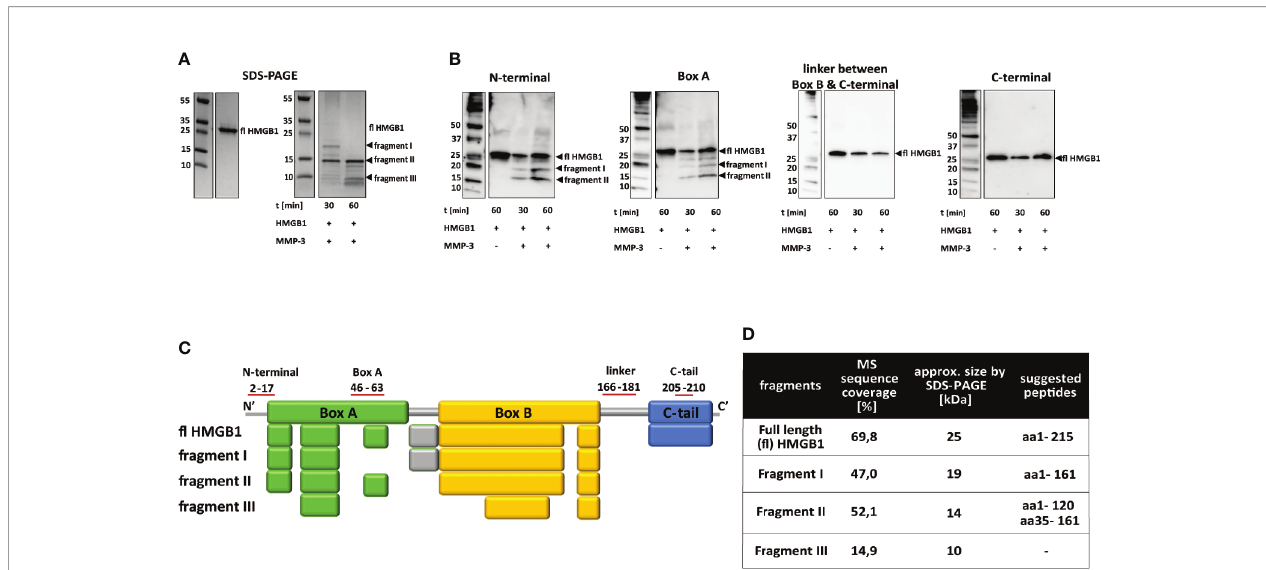
FIGURE 4 | MMP3 cleaves HMGB1 at multiple sites. (A) Left panel: SDS-PAGE showing full length HMGB1. Right panel: SDS-PAGE showing cleavage by MMP3 over time. Two distinct fragments of approximately 19 and 14 kDa (I and II) appeared at time point 30 min. At 60 min, fragment I had disappeared while fragment II was still the dominant fragment. (B) Western blotting of HMGB1 fragments after processing with MMP3. A fragment corresponding to fragment I in size was detected by the antibodies speci fi c for epitopes in the N-terminal region and in the box A region. In agreement with the SDS-PAGE kinetic pattern, the staining was stronger at the 30-min time point than the 60-min time point. Antibodies speci fi c for epitopes within the B-to-C linker region and the C-terminal region only detected full length HMGB1 and none of the fragments. (C) Gel bands of HMGB1 fragments I-III were analyzed by mass spectrometry and the resulting peptides were compared to peptides detected in the full length protein. Colored boxes refer to the functional domains of the HMGB1 in which peptides could be identi fi ed (Box A: Green, linker region: grey, box B: yellow, C-terminal tail: blue). (D) Suggested cleavage sites based on data in (A – C) together with literature and database searches.